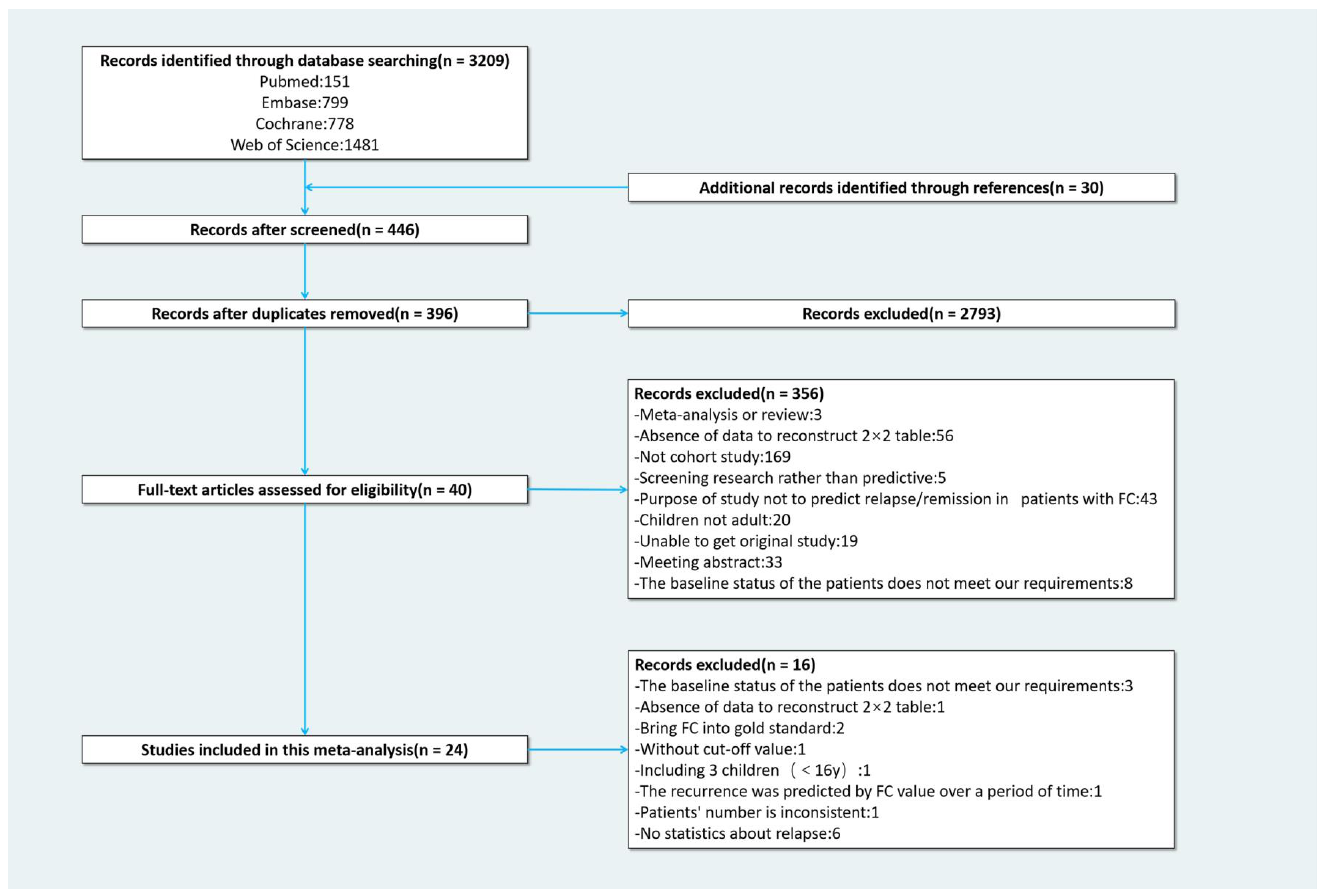
Figure 1. Flow chart of selection process.